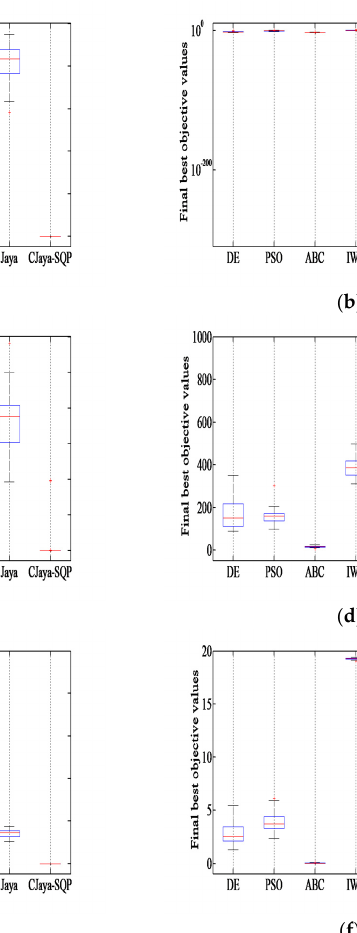
Figure 11. Boxplot of final best objective values obtained by different algorithms over 30 runs on the 100-dimensional conventional problems: ( a ) f 2 Schwefel 1.2; ( b ) f 3 Schwefel 2.22; ( c ) f 5 Rosenbrock; ( d ) f 6 Rastrigin; ( e ) f 7 Salomon; and ( f ) f 8 Ackley.